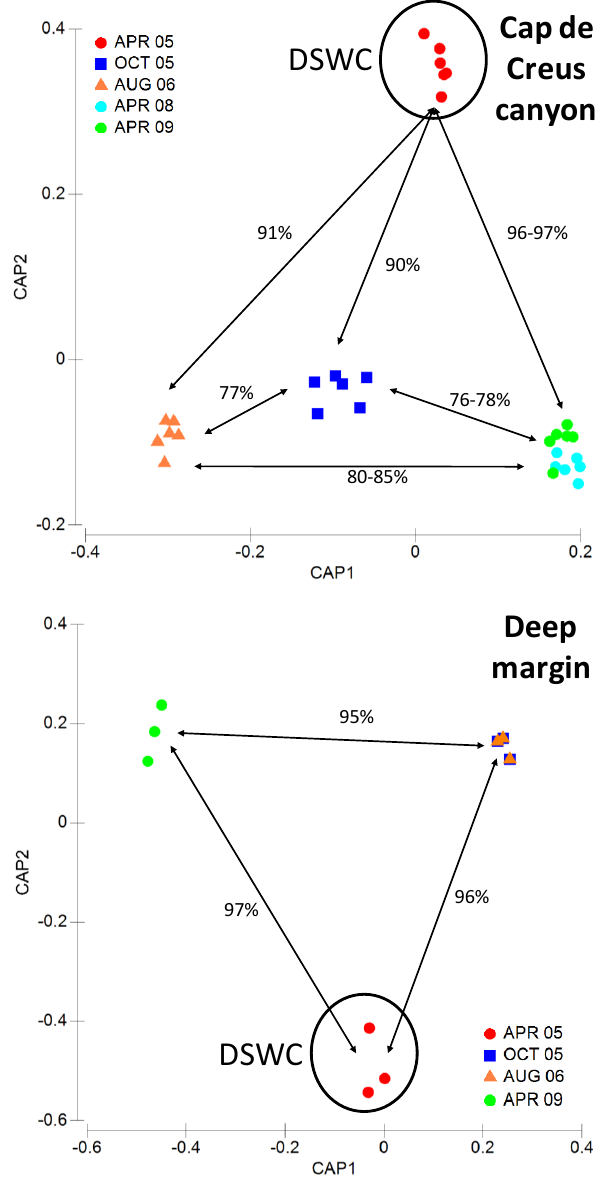
Fig. 5. Biplot after canonical analysis of principal coordinates illus- trating temporal variability in the composition of nematode assem- blages in the Cap de Creus Canyon (upper panel) and deep mar- gin (lower panel). Also reported is the percentage of dissimilarity among nematode assemblages in different sampling times, calcu- lated after SIMPER analysis. Red bars indicate